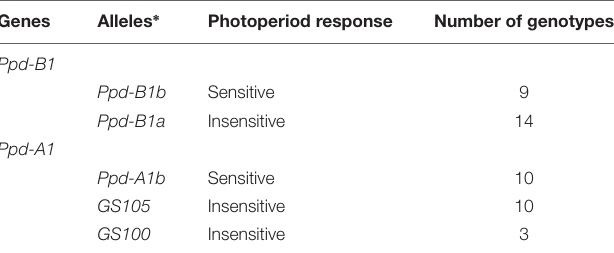
TABLE 2 | Allelic variants at Ppd-A1 and Ppd-B1 present in a collection of 23 spring durum wheat genotypes obtained through a divergent selection process for flowering time.